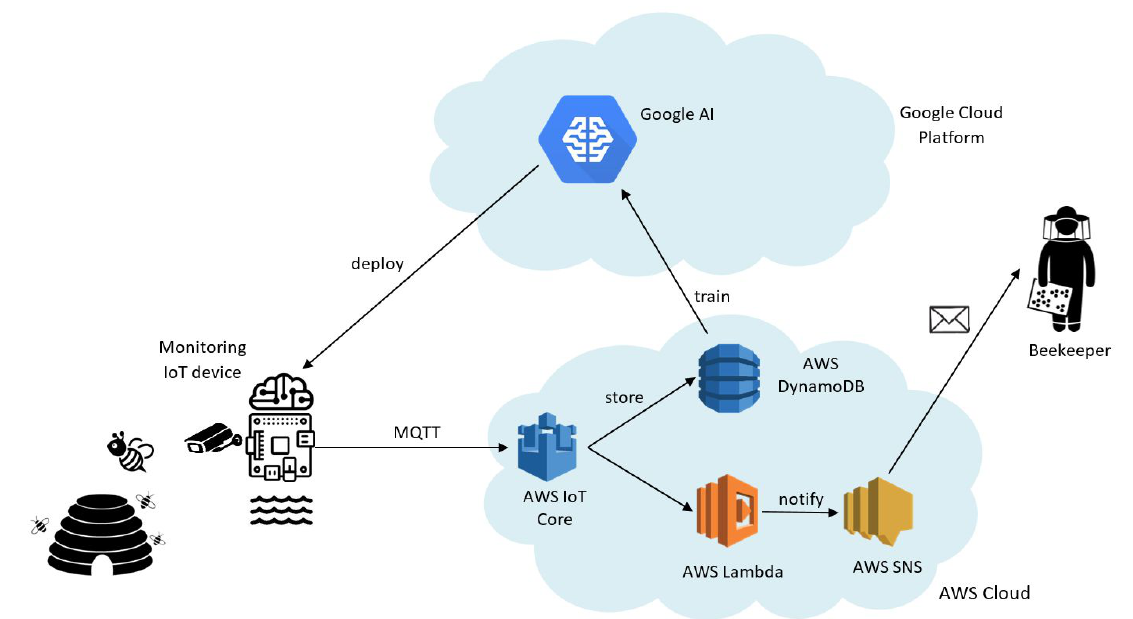
Figure 3. The architecture of the Edge- and Cloud-based experimental environment for monitoring bees and detection of